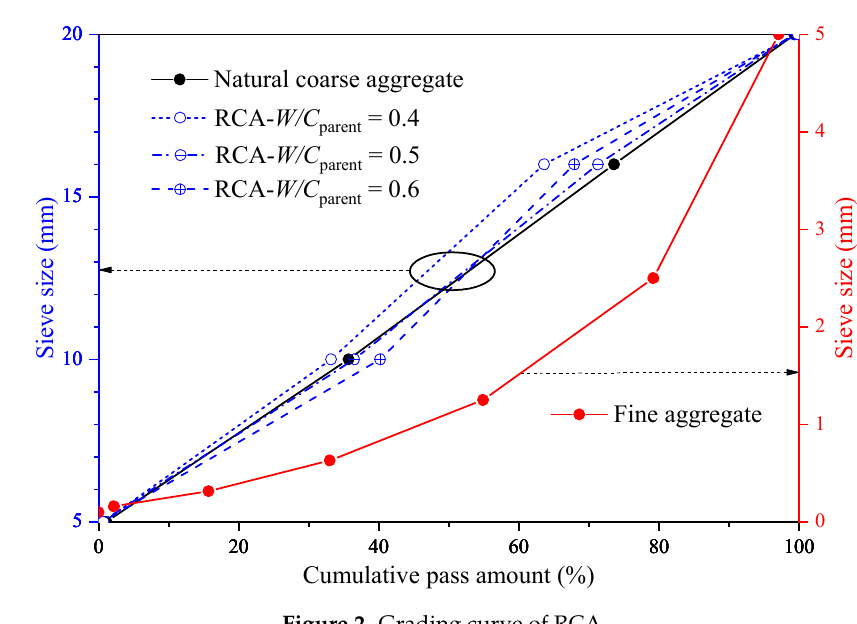
Figure 2. Grading curve of RCA. Table 1. Concrete mix proportion (kg/m 3 ).